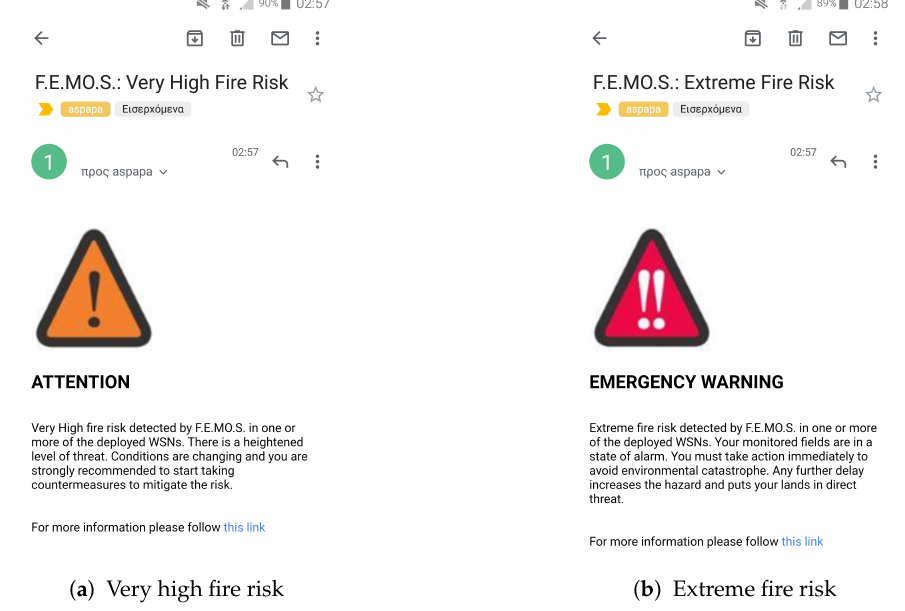
Figure 14. F.E.MO.S. automated notification alert messages for the cases of ( a ) very high and ( b ) extreme fire risk